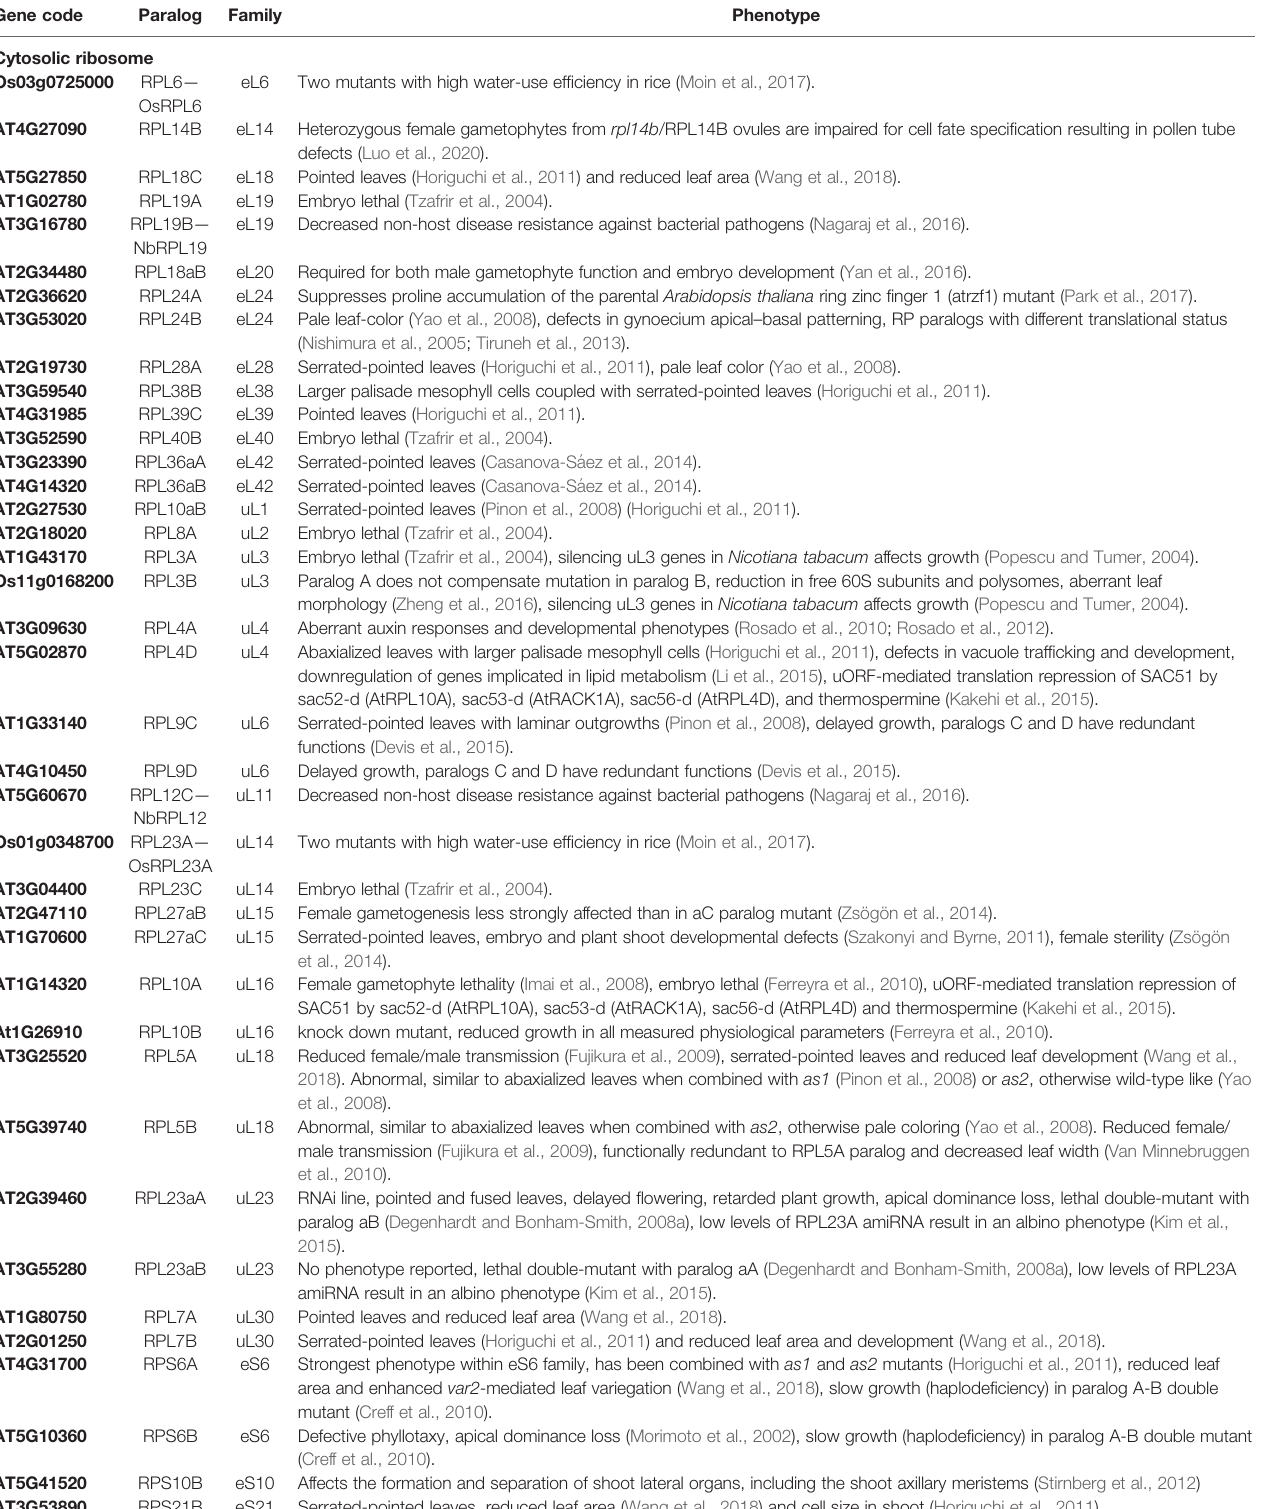
TABLE 2 | Studies of structural ribosomal protein mutant lines of Arabidopsis thaliana , Oryza sativa , Nicotiana tabacum , and Nicotiana benthamiana sorted by RP family. Gene